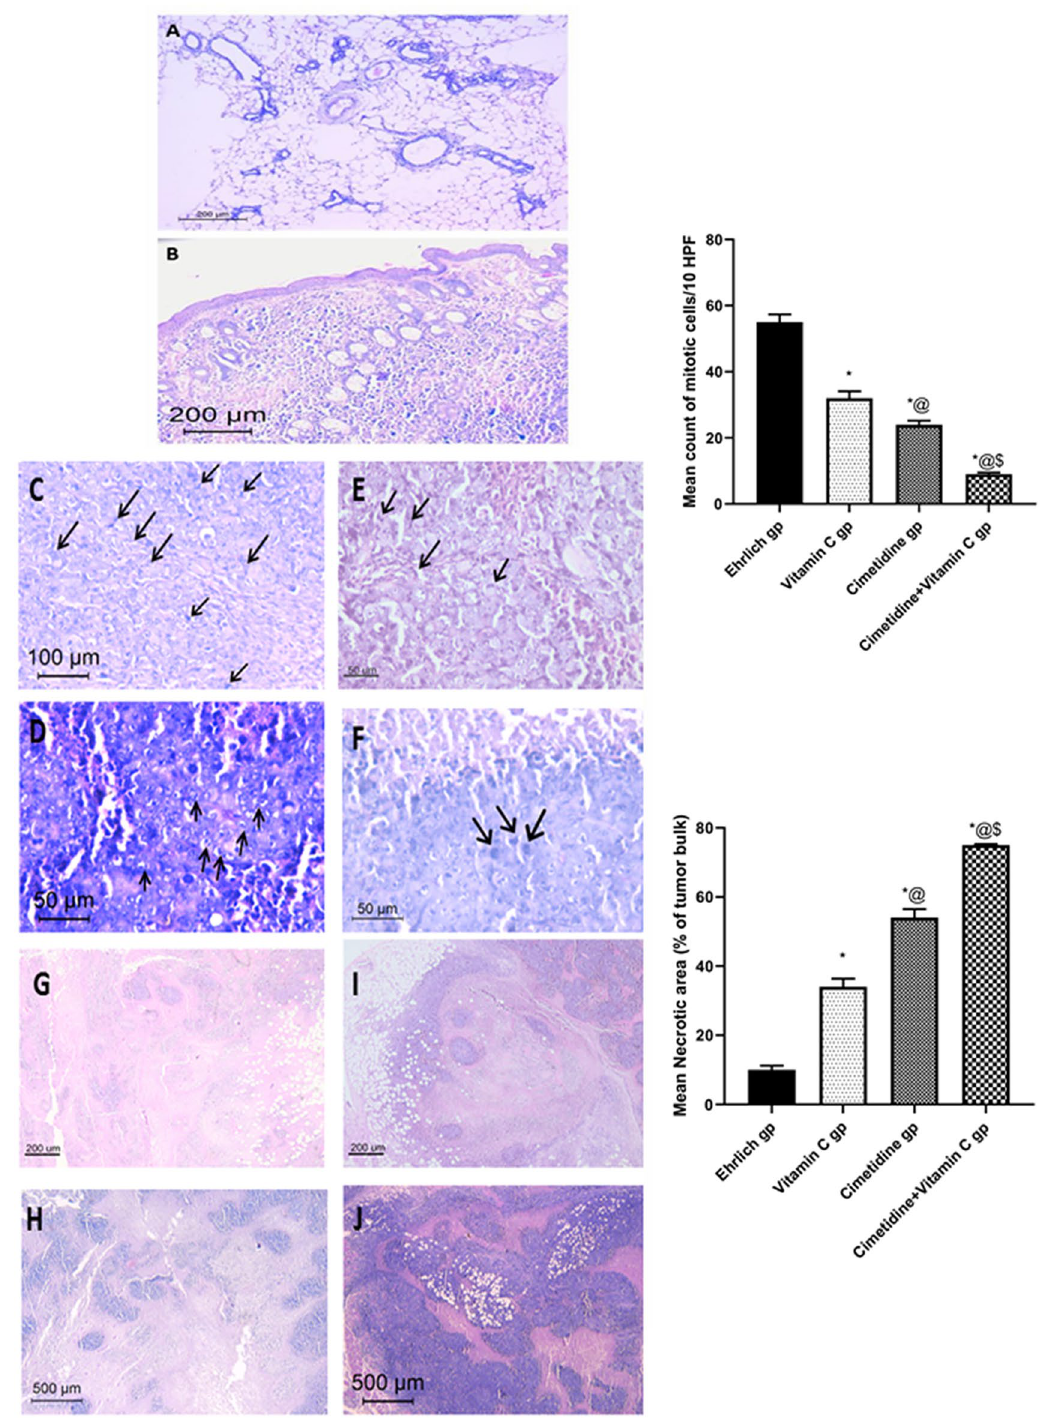
Figure 12. Histopathological and histomorphometric assessment using H and E for normal mammary fat pad and Ehrlich induced breast solid tumor in untreated mice and different treated groups with cimetidine at a dose of 200 mg/kg/day, vitamin C at a dose of 4 g/kg/day, and their combination for 15 days. Data are presented as mean ± SD.* Significantly different from the normal control group, P < 0.05. @ is significantly different from Ehrlich untreated group, P < 0.05. $ is significantly different from the vitamin C-treated group, P < 0.05. # is significantly different from the cimetidine-treated group, P < 0.05. ( A ) A normal control mice breast shows normal breast lobules and ducts. ( B ) Ehrlich tumor invades the entire breast tissue. ( C ) Untreated Ehrlich tumor shows numerous mitotic figures. ( D ) Mild reduction in mitotic figures is shown in breast solid tumor after treatment with vitamin C. ( E ) Moderate reduction in mitotic figures is shown in breast solid tumor after treatment with cimetidine. ( F ) The most prominent reduction is shown in breast solid tumor after treatment with the combination of cimetidine and vitamin C. ( G ) Ehrlich tumor is composed of sheets and masses of large polygonal epithelioid cells, with central areas of necrosis. ( H ) Demonstrates mild elevation in the extent of necrosis within the tumors after vitamin C treatment. ( I ) Reveals moderate elevation in the extent of necrosis within the tumors after cimetidine treatment. ( J ) Indicates the most prominent elevation in the extent of necrosis within the tumors after treatment with the combination